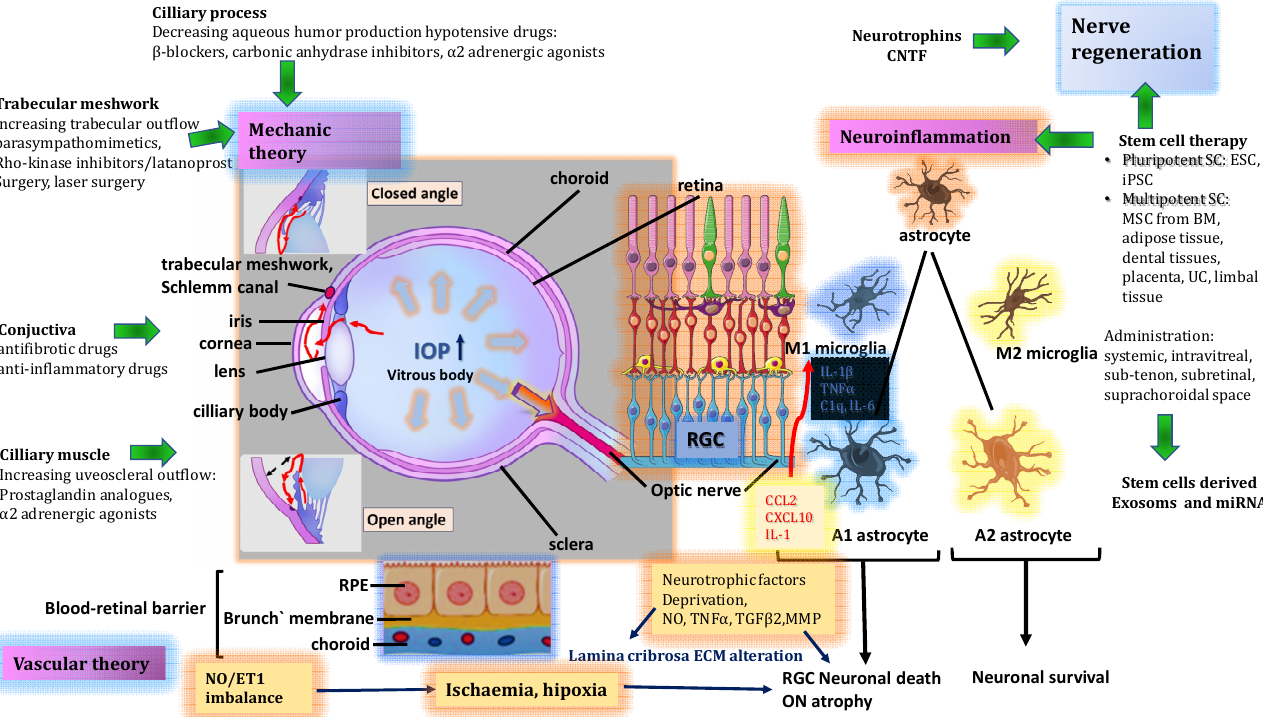
Figure 1. The main pathophysiological mechanisms in glaucoma and the mode of action of existing therapies in the clinical practice.